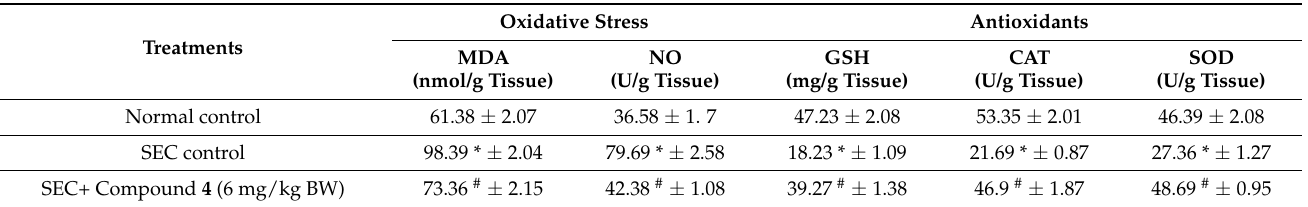
Table 4. Assessment of hepatic oxidant/antioxidant activities in the studied groups of SEC-bearing mice.